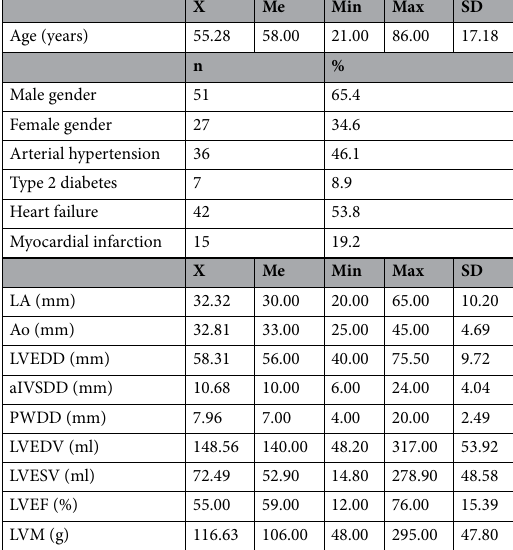
Table 1. Clinical characteristics of the studied group of patients (n = 78). aIVSDD anterior interventricular septum diastolic dimension, Ao aortic root dimension, LA left atrium dimension, LVEF left ventricular ejection fraction, LVEDD left ventricular end-diastolic diameter, LVEDV left ventricular end-diastolic volume, LVESV left ventricular end-systolic volume, LVM left ventricular mass, Max maximum value, Me median, Min minimum value, n number of patients, PWDD posterior wall diastolic dimension, SD standard deviation, X arithmetic